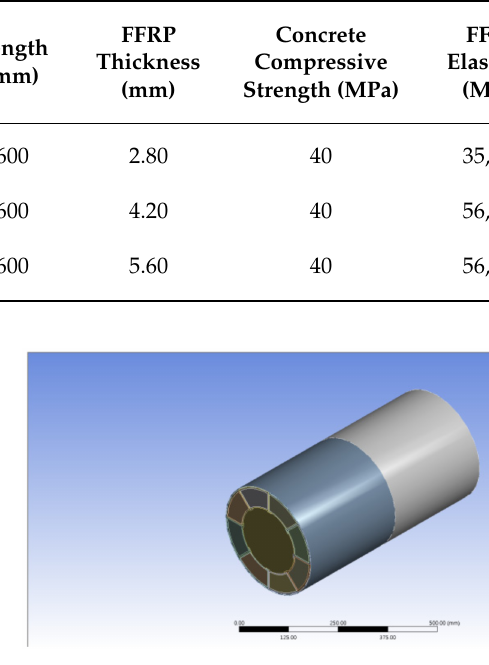
Figure 20. Finite element analysis (FEA) model for compressive behavior of the hybrid −